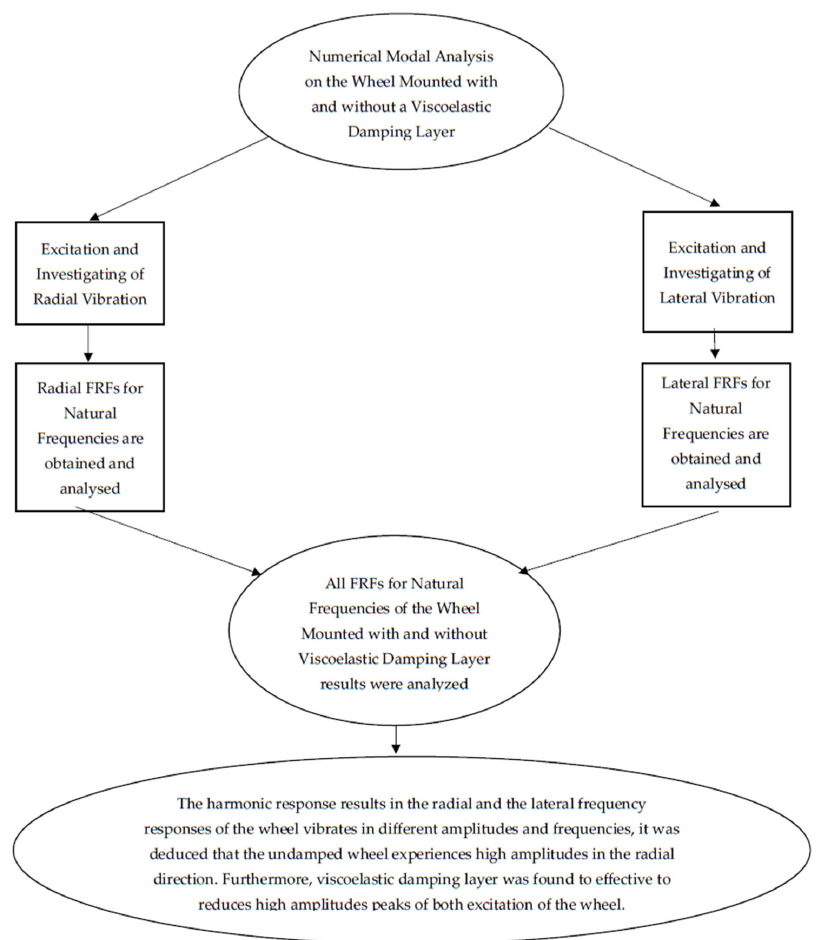
Figure A4. Experimental modal analysis scheme.